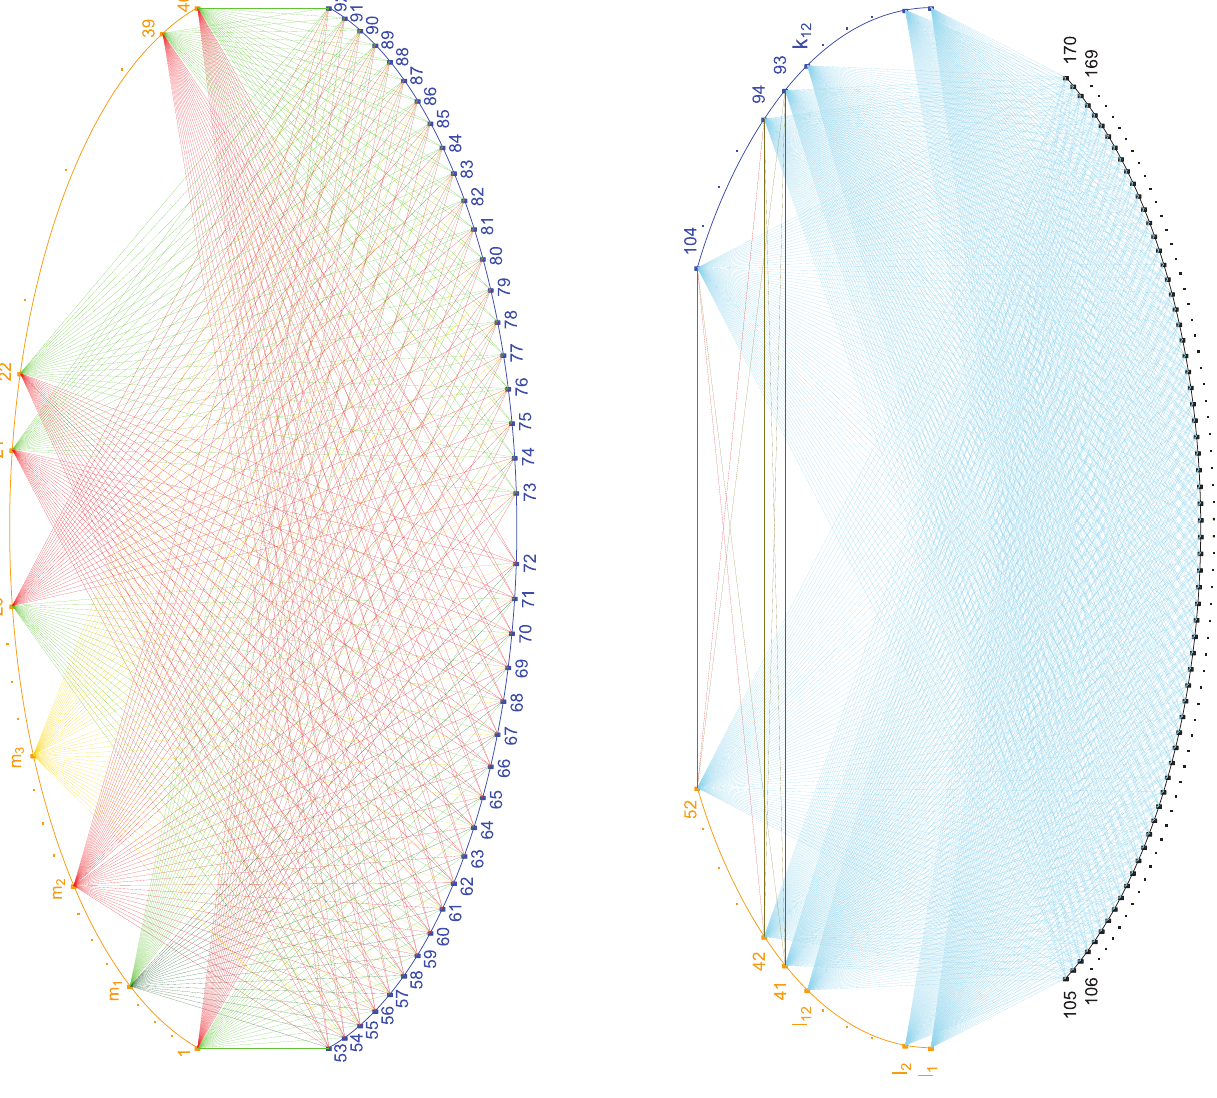
Figure 2. Illustration of sampling probabilities for simulated data set two. Left figure: Pair set one. All orange points (fragments 1–40) are connected to all blue points (fragments 53–92), either by dark green, green, red or gold lines. Fragments 1–20 (except m 1 , m 2 and m 3 ) and fragment 53–72, also fragments m 1 , 21–40 and fragments 73–92, are connected by green lines. Fragment m 1 and fragments 53–72 are connected by dark green lines. Fragment m 3 and fragments 53–92 are connected by gold lines. All other lines are red. The ratio of the four sampling probabilities for a dark green line, to that for a green line, to that for a red line, to that for a gold line is 12 : 6 : 3 : 1 . Right figure: Pair set two. All orange points (fragments 41–52 and fragments l 1 – l 12 ) and all blue points (fragments 93–104 and fragments k 1 – k 12 ), are connected to all black points (fragments 105–170) by sky blue lines. Fragments 41–52 are connected to fragments 93–104 either by gold or red lines. There are 10 red lines in the graph, with only 3 of them are shown for the sake of simplicity. The ratio of the sampling probability for a red line to that for a sky-blue/gold line is 3 : 1 . The sky- blue lines and gold lines (in both figures) represent false pairs and were assigned the same sampling probabilities.